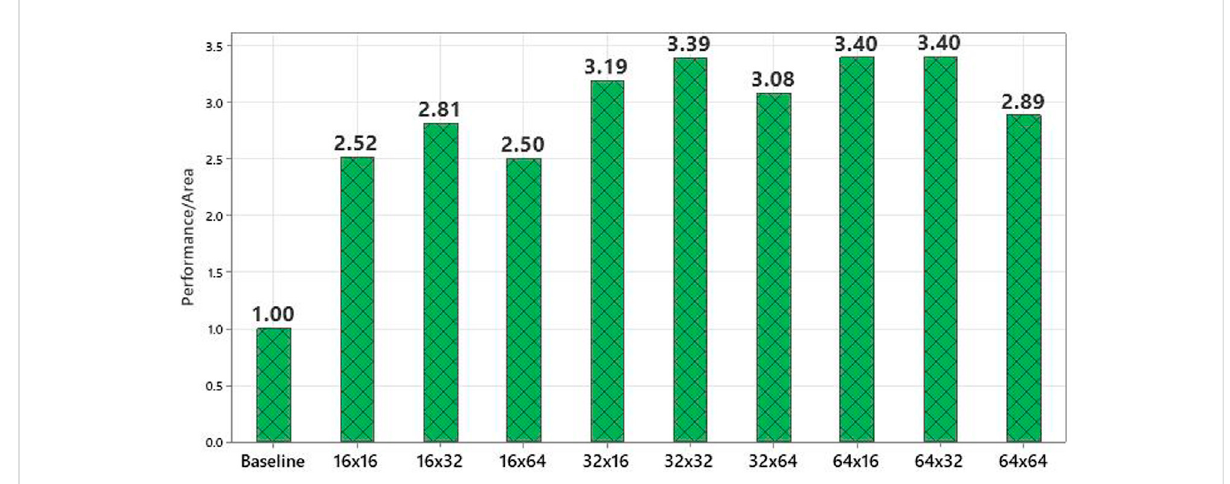
FIGURE 13 Improvement in Figure of Merit for AI-PiM (percentage performance gain/percentage area overhead) compared to RV64IMC 5-stage RISC-V processor baseline.